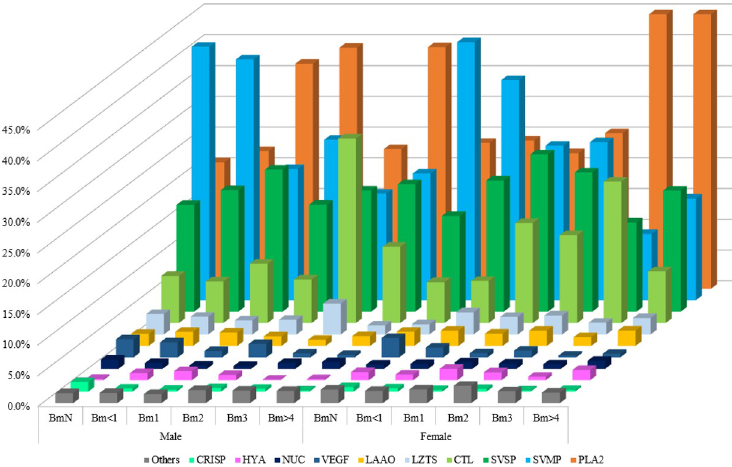
Fig 5. Overview of protein families’ abundances in male and female B . moojeni venoms at different ages. All venom pools were subjected to LC-MS/MS, and proteins were identified, quantified, and assigned to each protein family expressed as percentage. CRISP: cystein-rich secretory protein; HYA: hyaluronidase; NUC: nucleotidase; VEGF: vascular endothelial growth factor; LAAO: L-amino acid oxidase; LZTS: leucine zipper tumor suppressor; CTL: C-type lectin; SVSP: snake venom serine protease; SVMP: snake venom metalloprotease; PLA 2 : phospholipase A 2 . Others: included families that accounted for < 1% in all venoms: bradykinin-potentiating peptide, calmodulin, disintegrin, flavin monoamine oxidase, glutaminyl-peptide cyclotransferase, Kunitz-type serine protease inhibitor, nerve growth factor, phosphodiesterase, phospholipase B, phospholipase A 2 inhibitor, TNF receptor-associated factor 6, and waprin.